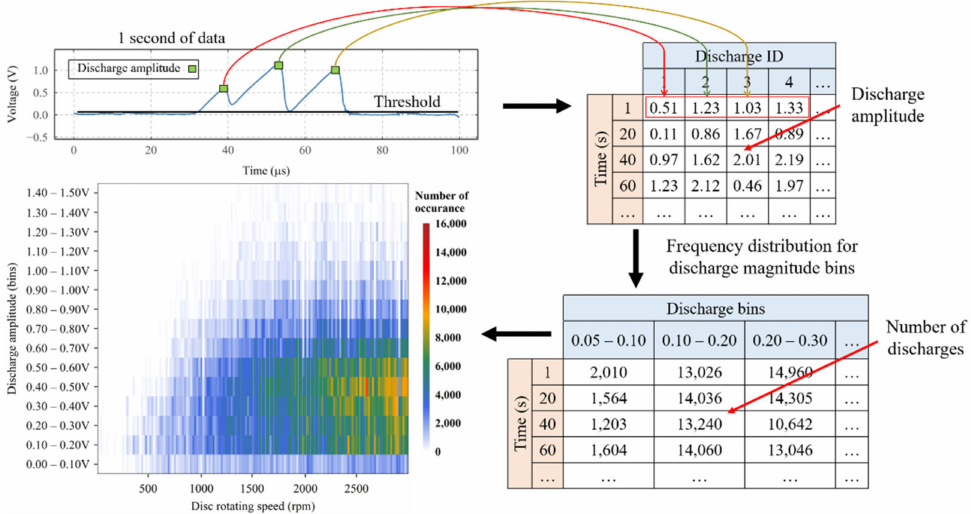
Figure 10. Schematics of the quantification algorithm developed in this study to evaluate the fre- quency distribution of electrical discharges in multiple discharge bin